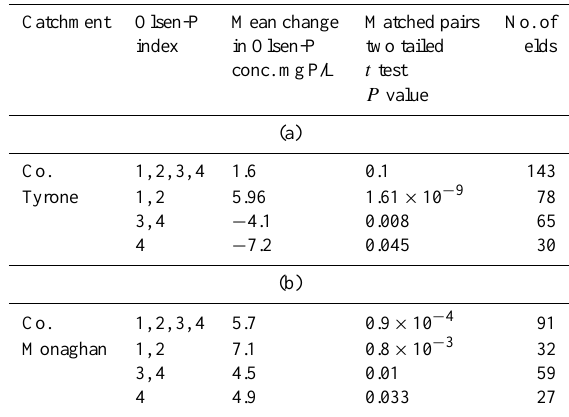
Table 1. Summary of change in Olsen-P concentration for all soil indices in the Co. Tyrone (a) and Co. Monaghan (b) sub- catchments.